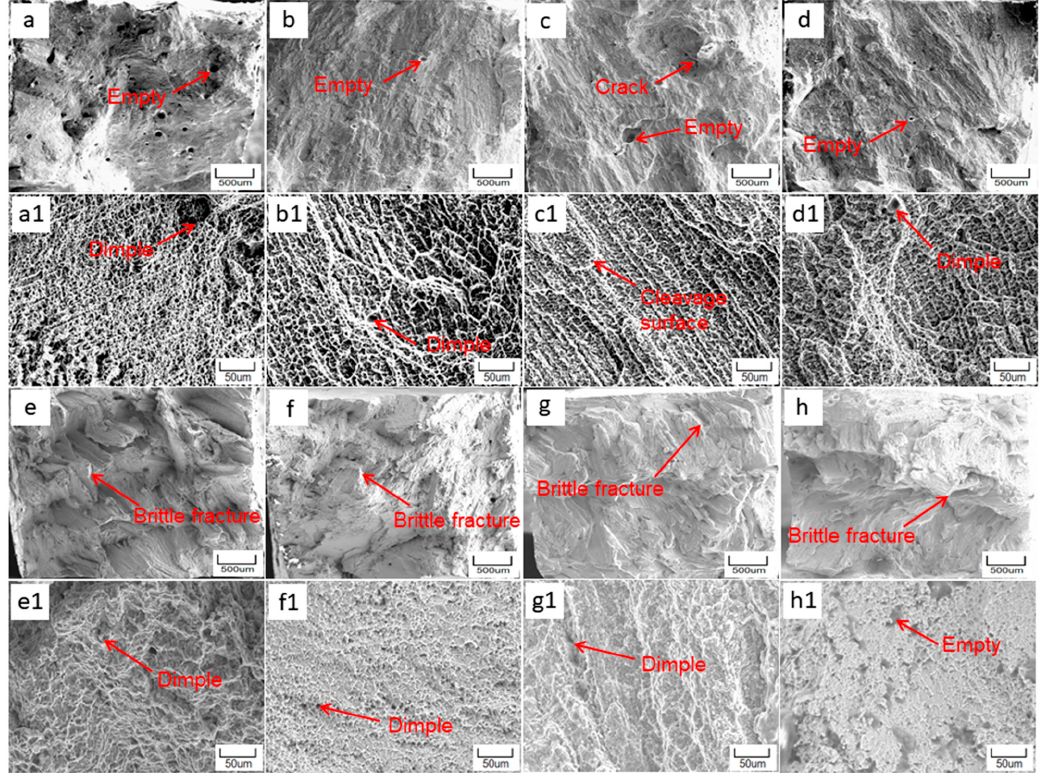
Figure 8. Tensile fracture of four coatings at normal temperature and 850 °C before and after heat treatment (( a , a1 , e , e1 ) IN65, ( b , b1 , f , f1 ) 1#, ( c , c1 , g , g1 ) 2#, ( d , d1 , h , h1 ) 3#).